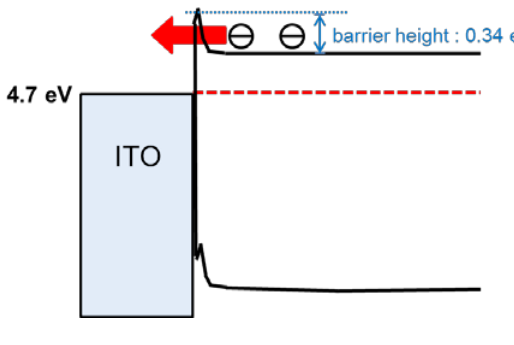
contact measured by Kelvin band 60